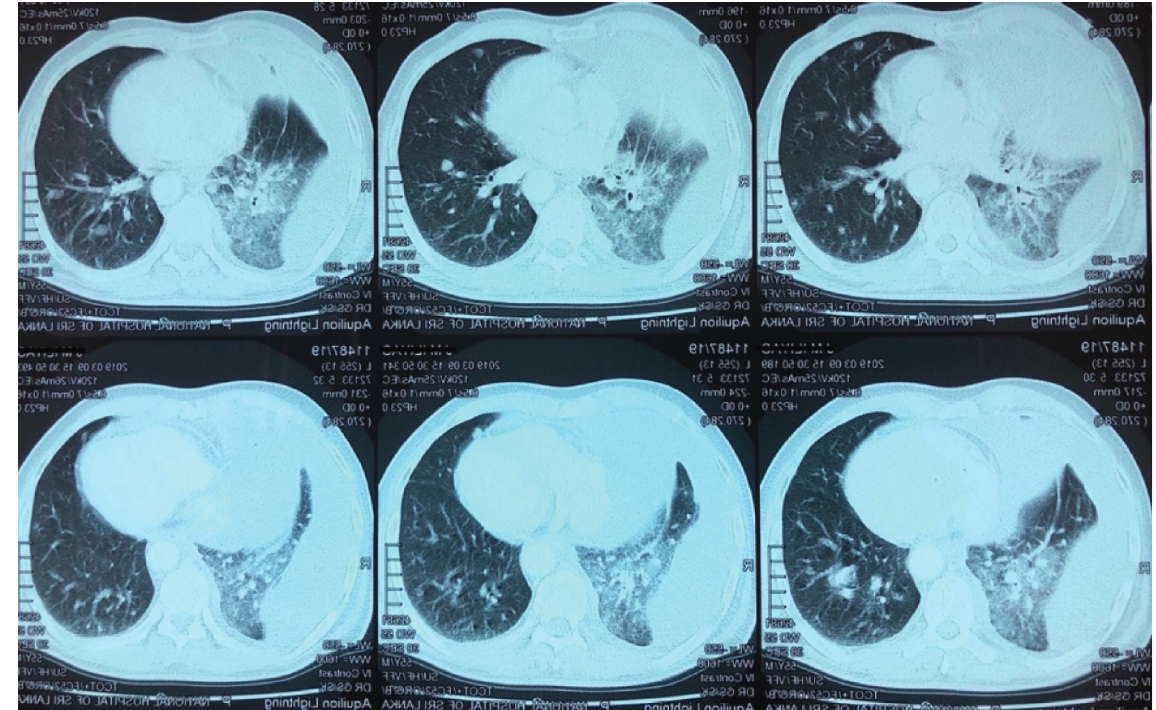
Figure 3: CECTchest—ill-defined enhancing malignant lesion—obliterating the right upper bronchus, right upper lobe, pulmonary artery, and